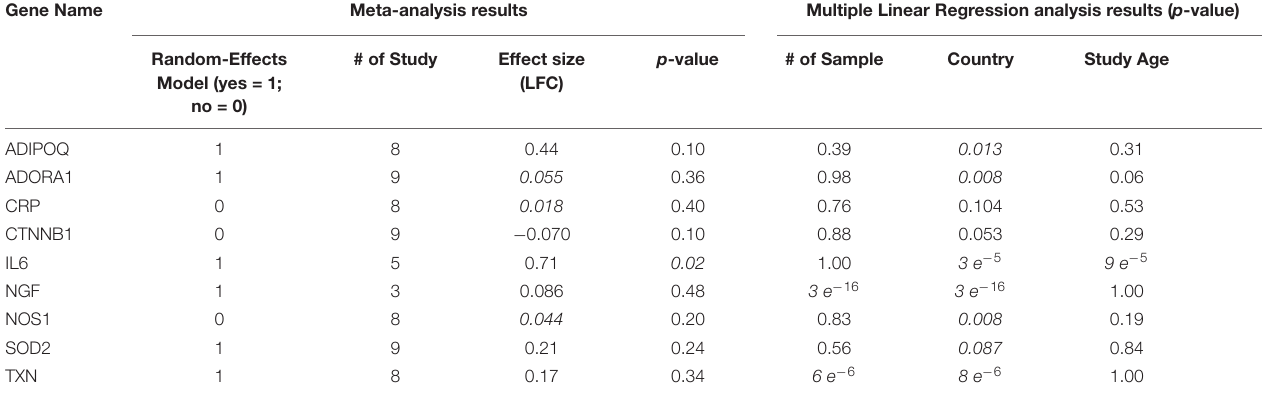
FIGURE 1 | Schizophrenia driven genetic regulators of myocardial infarction. Each relationship was supported by three or more references. The network contains four different types of proteins and three different types of relationships (edges). Genes in red represent an increased gene expression level in myocardial infarction, and blue means decreased. TABLE 2 | Meta-analysis and Multiple Linear Regression analysis